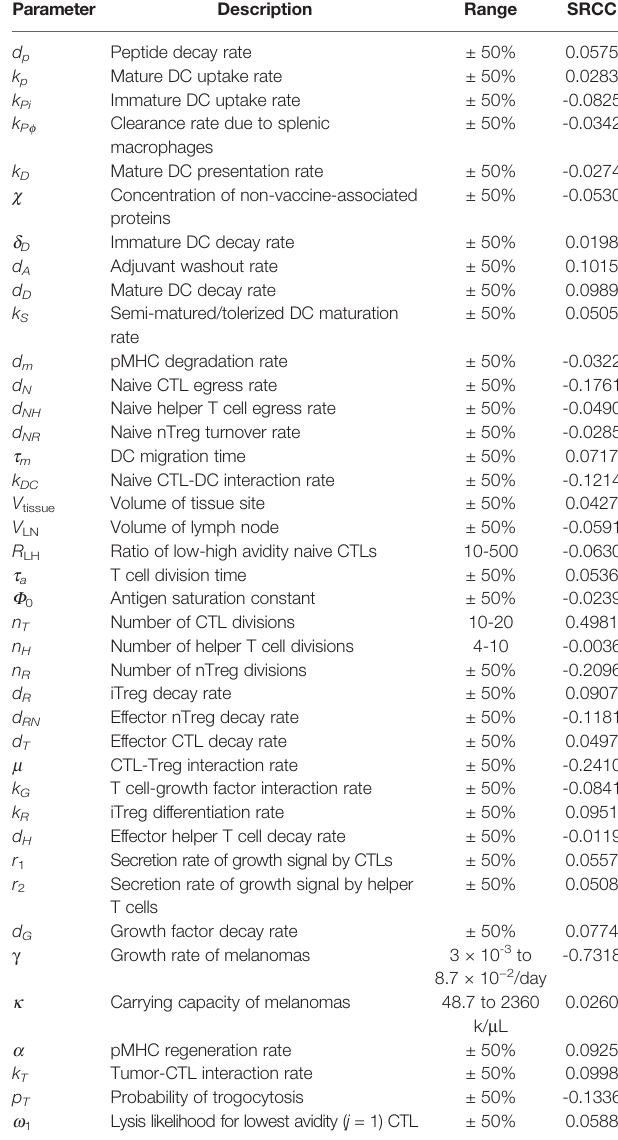
TABLE 2 | Spearman ’ s rank correlation coef fi cient between modi fi ed model parameters and fold decreases of simulations when varied simultaneously.